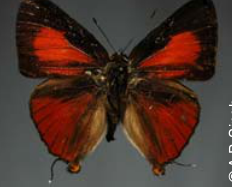
Image 31. Bi-Spot Royal, Ancema ctesia (under)